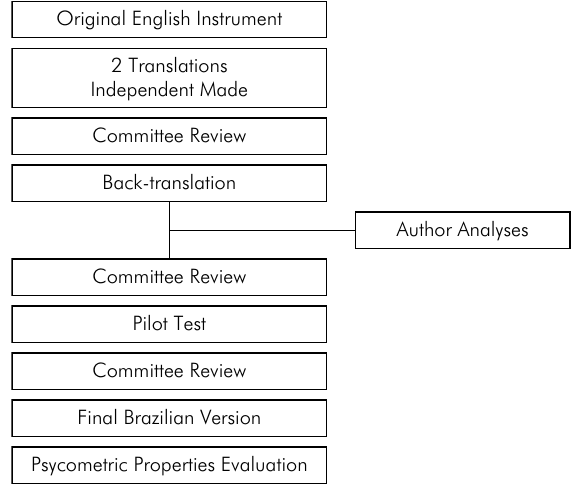
Figure. Flow chart of the translation and cross-cultural adaptation